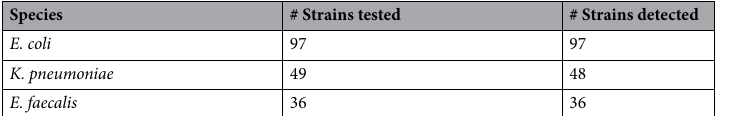
Table 1. Inclusivity of MultiPath assays. Uropathogen-specific MultiPath assays were carried out in PBS spiked with about 1 × 10 5 CFU/mL of various strains. Strains were obtained from commercial sources, provided by Assurance Scientific Laboratories or isolated from UTI patients’ urine collected under an IRB approved